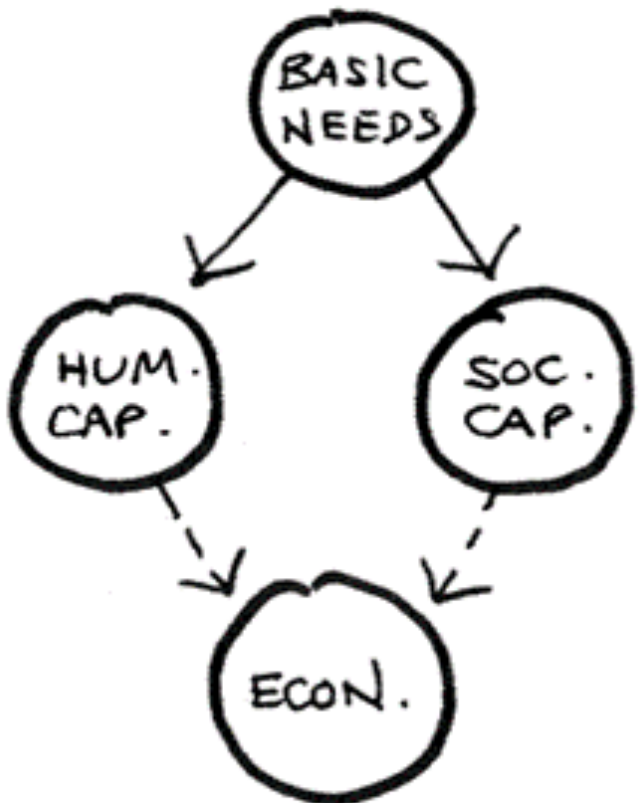
Figure 1. Relationships of social to environmental and economic components. (Strener,